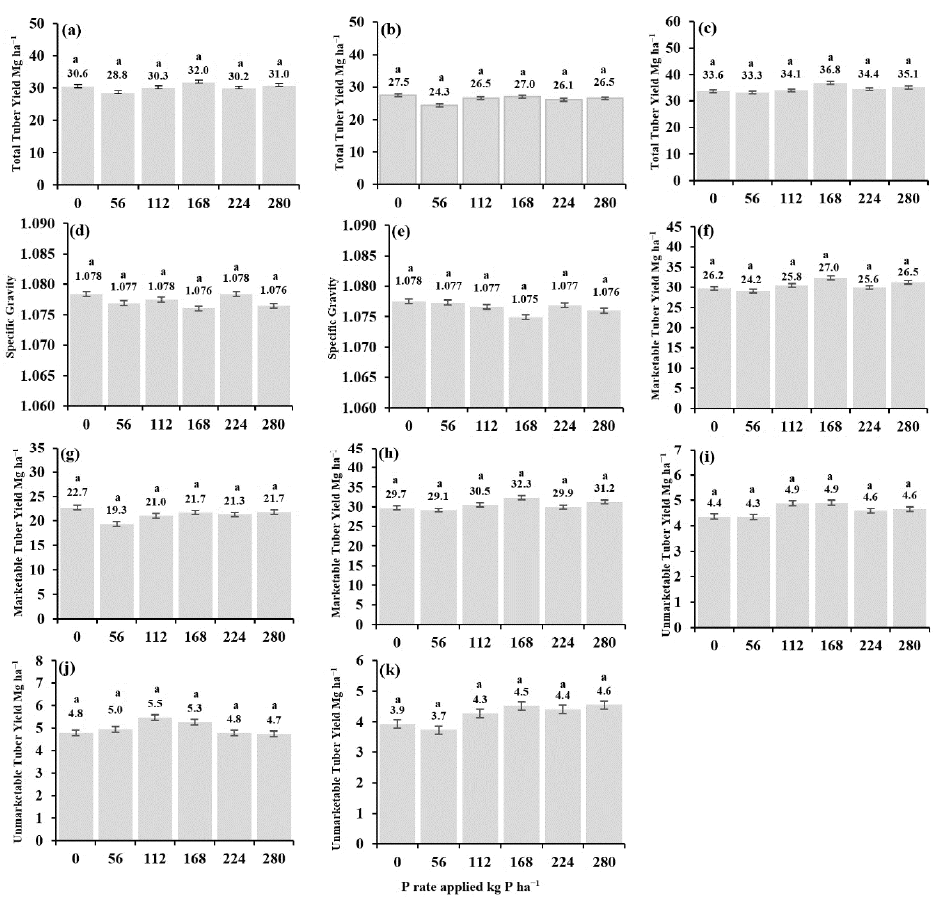
Figure 4. Effect of P rates on total tuber yield at all sites combined ( a ), all sites combined at soil pH ≥ 6 ( b ), all sites at soil pH < 6 ( c ), specific gravity at all sites combined at soil pH ≥ 6 ( d ), all sites at soil pH < 6 ( e ), marketable tuber yield at all sites combined ( f ), all sites combined at soil pH ≥ 6 ( g ), all sites at soil pH < 6 ( h ), and unmarketable tuber yield at all sites combined( i ), all sites combined at soil pH ≥ 6 ( j ), all sites at soil pH< 6 ( k ). Means connected by the same letter are not significantly different (Tuckey’s test P < 0.05).